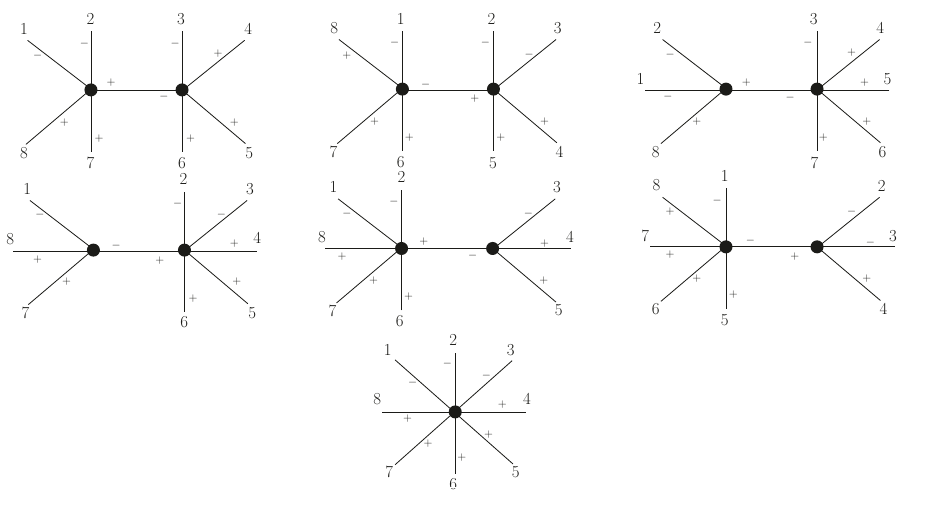
Figure 7 . Diagrams contributing to the 8-point NMHV amplitude ( − − − + + + ++)